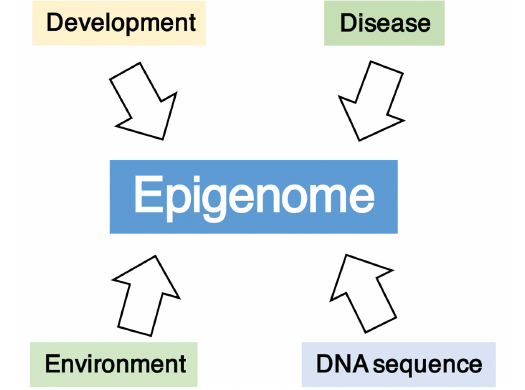
Figure 1: High level influences on the epigenome. The epigenome encompasses all of chemical information that is added to the genome in a cell, in particular via modification of histones or DNA. The origin of these patterns of modification is incompletely understood. There is particular interest in the role of the environ- ment, although the evidence supporting this route is sometimes controversial. This article considers that DNA sequence may be an under-appreciated determinant of the